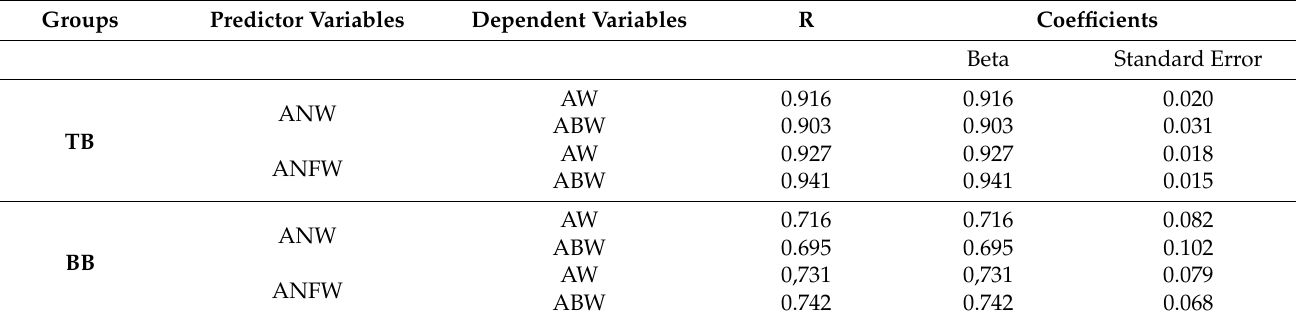
Table 5. Linear regression tests model using anterior skeletal changes as independent variables (predictor) and soft tissue changes as dependent